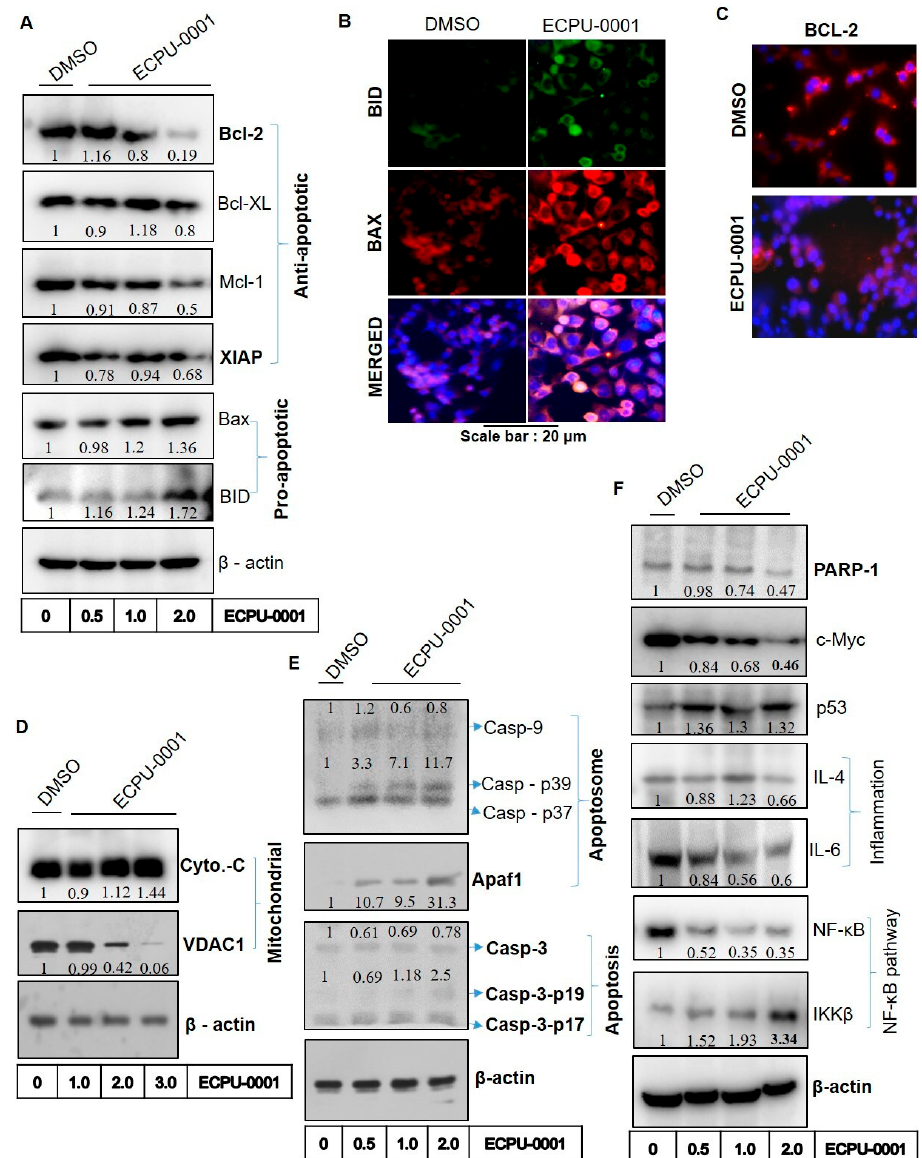
Figure 6. ECPU-0001 inhibits cancer growth of A549 through BCL-2 mediated mitochondrial apoptosis pathway. ( A ) Immunoblot study was done to investigate the protein levels of anti-apoptosis markers as Bcl-XL, BCL-2, XIAP, Mcl-1, apoptosis inducing markers as BID and BAX. ( B ) Immunocytochemistry study performed to evaluate role of ECPU-0001 in activation of BID and BAX. ( C ) Immunocytochemistry study showed significant reduction in BCL-2 protein levels in ECPU-0001 treated A549 cells. ( D ) Protein levels analysis by western blot for mitochondrial proteins Cyto-C and VDAC1. ( E ) ECPU-0001 augments apoptosome formation and showing the activation of caspases proteins. Immunoblot study for apoptosome inducer Caspase-9 and Apaf1 as well as apoptotic protein Caspase -3. Cells were treated with different concentration of ECPU-0001 for 24 h and then harvested. Total cell fractions were collected using RIPA buffer subjected to SDS PAGE followed as previously as described in Materials and Methods. ( F ) Western blot analysis was conducted for DNA repair protein PARP-1, oncogenic protein c-MYC, tumor suppressor protein p53, tumor inflammatory protein IL-4 and IL-6 as well as NF- κ B pathway proteins NF- κ B and IKK β .